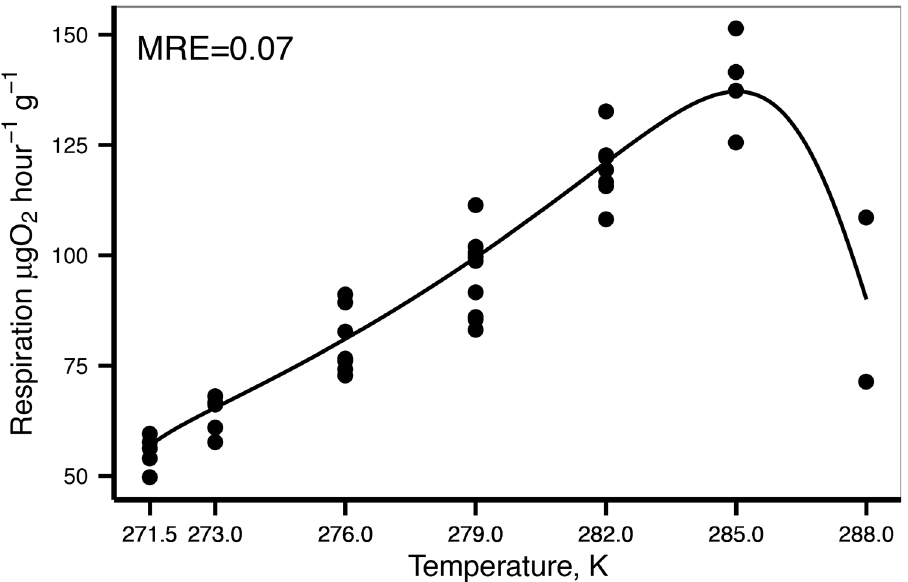
Fig 5. Oxygen consumption according to temperature. Dots are observed values for several individuals averaging 7.2 g wet weight [27]. The line represent DEB model predictions using the estimated values from Table 1. MRE is the mean absolute relative error.